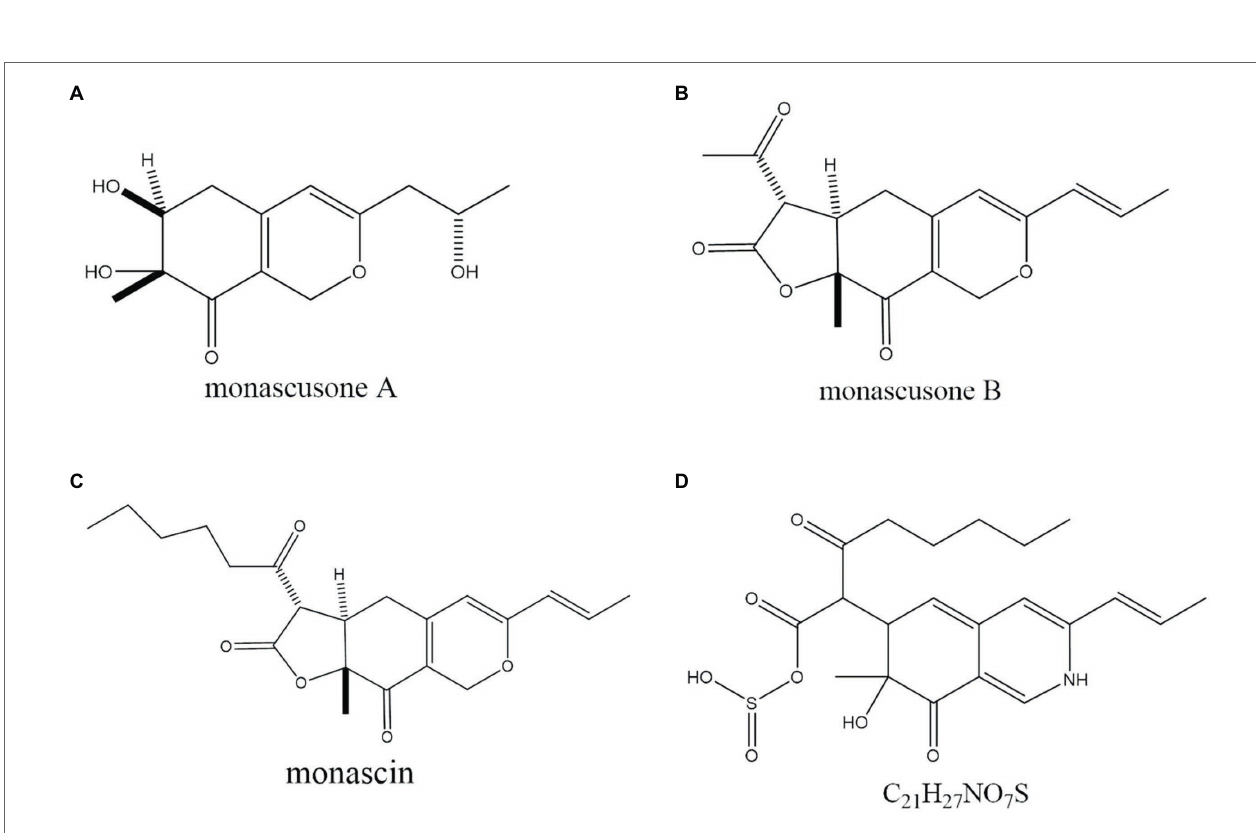
FIGURE 9 | The chemical structure of monascusone A (A) , monascusone B (B) , and monascin (C) , and C 21 H 27 NO 7 S (D)